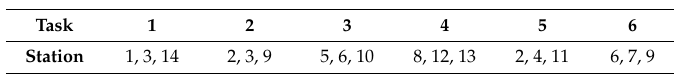
Figure 9. Convergence curves in the Monte-Carlo experiment.